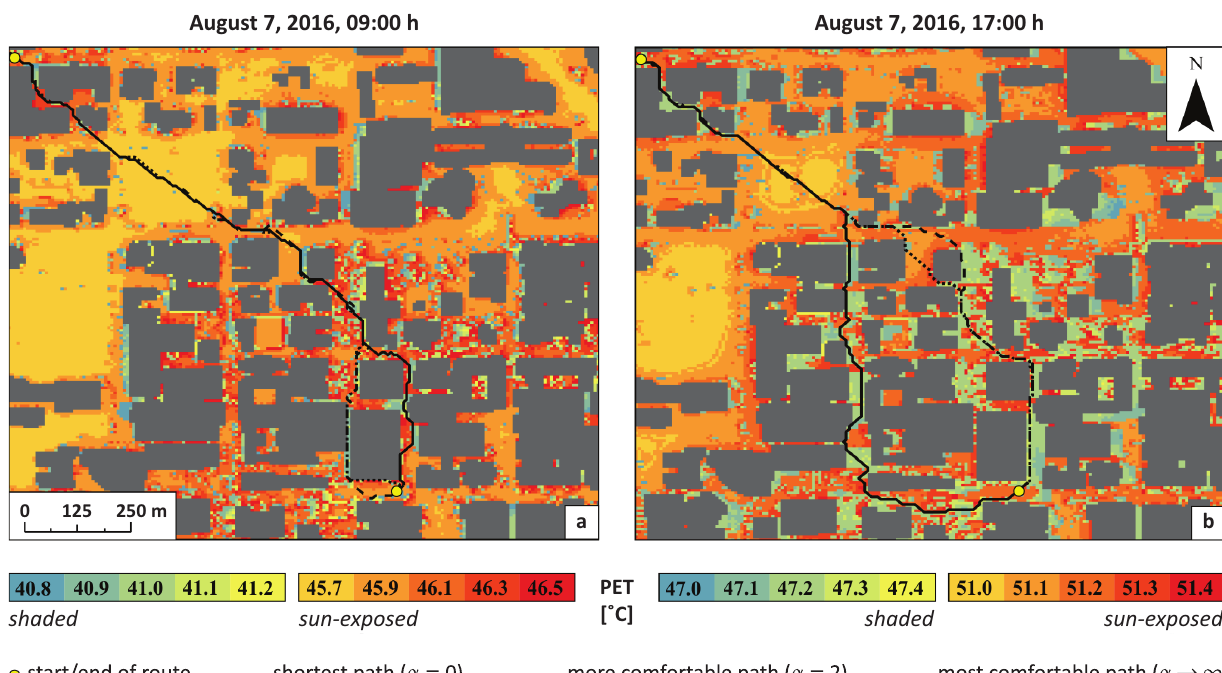
PET [˚C] shaded sun-exposed shaded sun-exposed